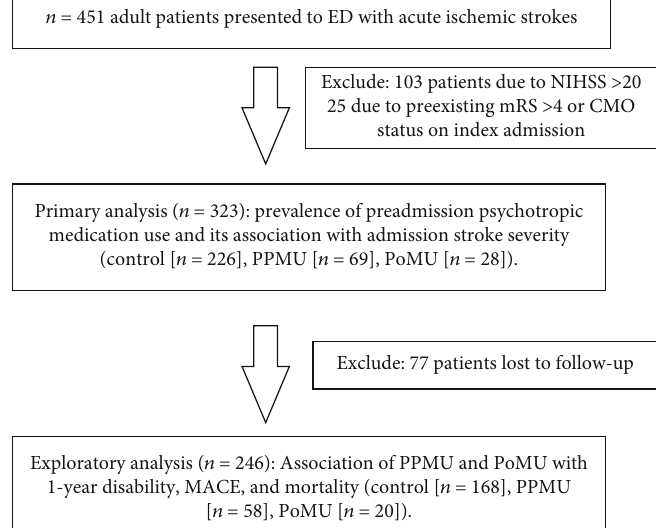
Figure 1: Patient fl ow